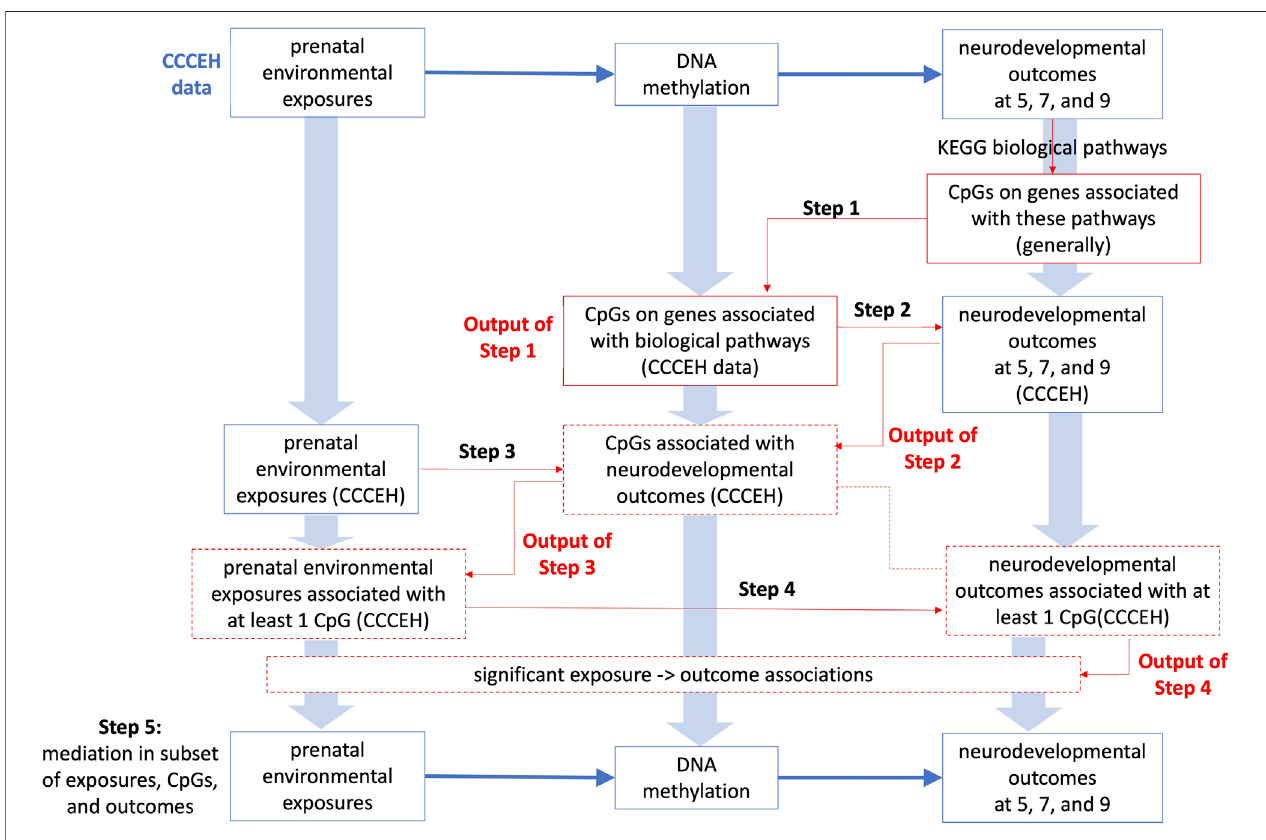
FIGURE 1 | Overview of fi ve steps.